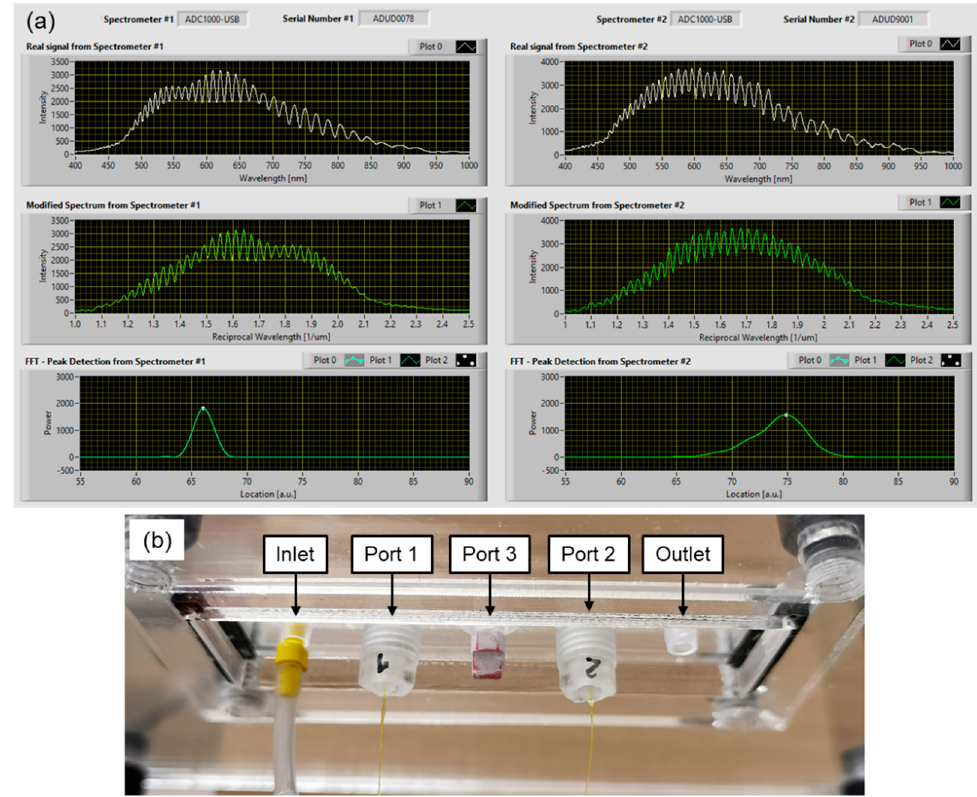
Figure 5. ( a ) Reflection spectra acquired by the spectrometers when the FOP-MIV sensors are connected to the interrogation system, and ( b ) close-up on the FOP-MIV sensors attached to the microfluidic device via Port 1 and Port 2.